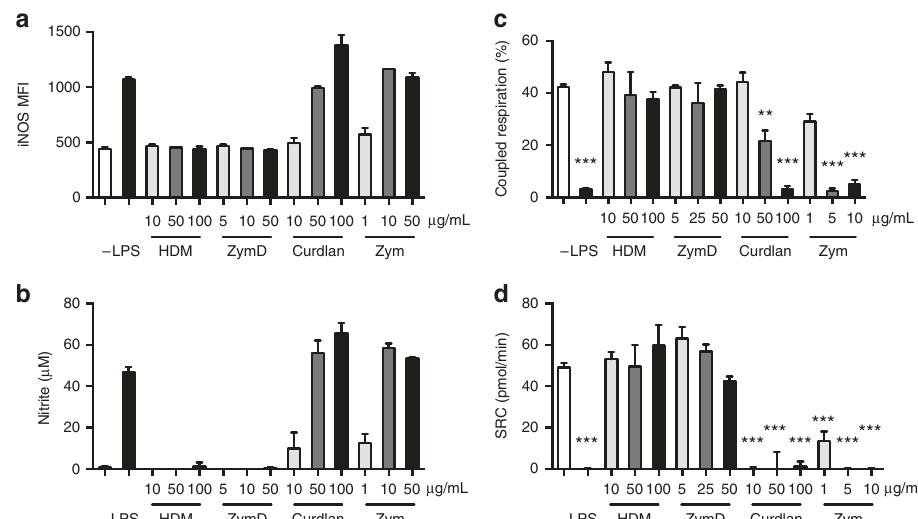
Fig. 3 iNOS expression and NO production is correlated with loss of coupled respiration. DCs were stimulated for 18 h by activators at the indicated doses ( μ g/mL). a Geometric MFI of iNOS, b nitrite (NO 2 − ) production, c coupled respiration, and d SRC were measured as described in Methods and in Fig. 1. Data shown are from one experiment representative of three experiments (mean and s.d. of duplicates ( a , b ) and s.e.m. of four to six replicates ( c , d )). Data were analyzed using a one-way ANOVA. *** p < 0.001, ** p <